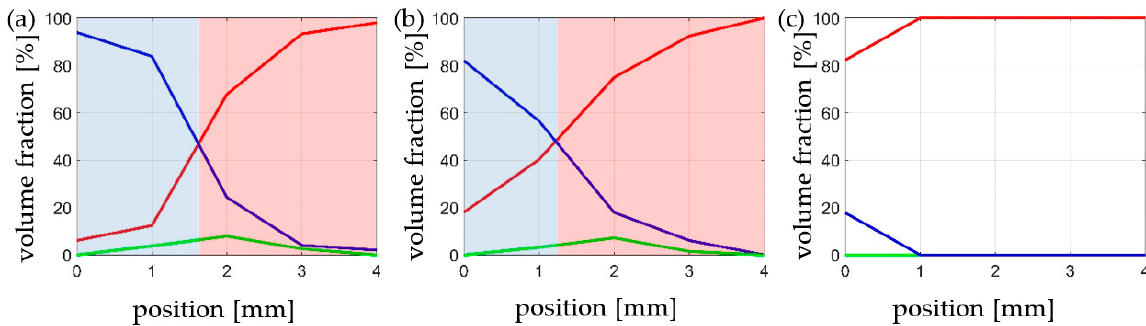
Figure 4. Volume fraction of austenite (red line), α ’ martensite (blue line), and ε martensite (green line) as a function of a distance from the fracture surface for the specimens stretched at different temperatures: ( a ) 4.2 K, ( b ) 77 K, and ( c ) room temperature.